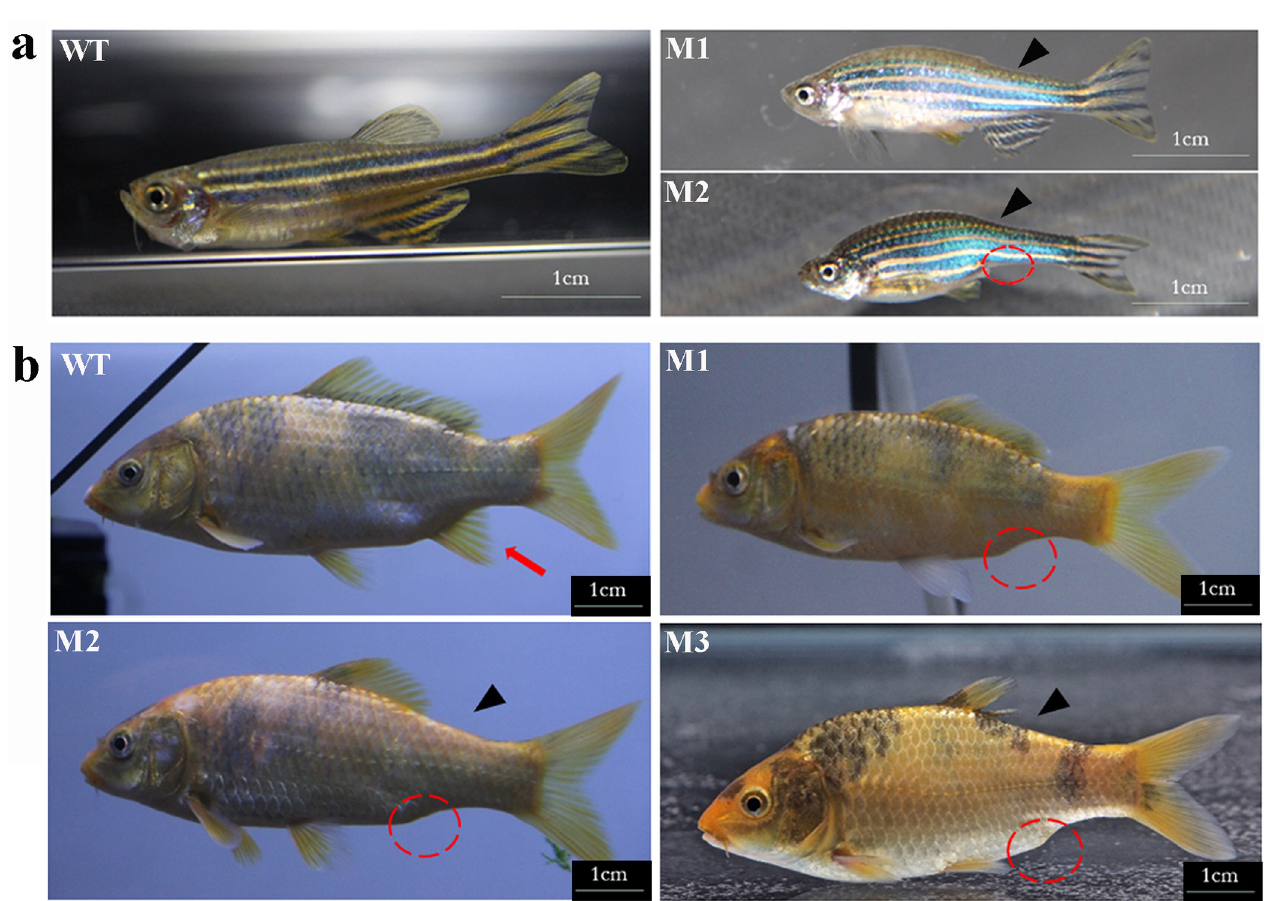
Fig 4. Phenotypic comparison between zebrafish and color common carp eomesa mutants. (a) Lateral view of wild type and eomesa mutant zebrafish. Compared to the wild type, the eomesa fh105 mutants exhibit two phenotypes. All mutants exhibit the phenotype with no dorsal fin. Rare mutants exhibit the phenotype with no dorsal fin and anal fin. (b) Lateral view of four-month-old wild type and eomesa mosaic mutants of color common carp. Compared to the wild type, three mosaic mutants (M1-M3) exhibit different degrees of deformity in the dorsal fins and complete loss of anal fins.